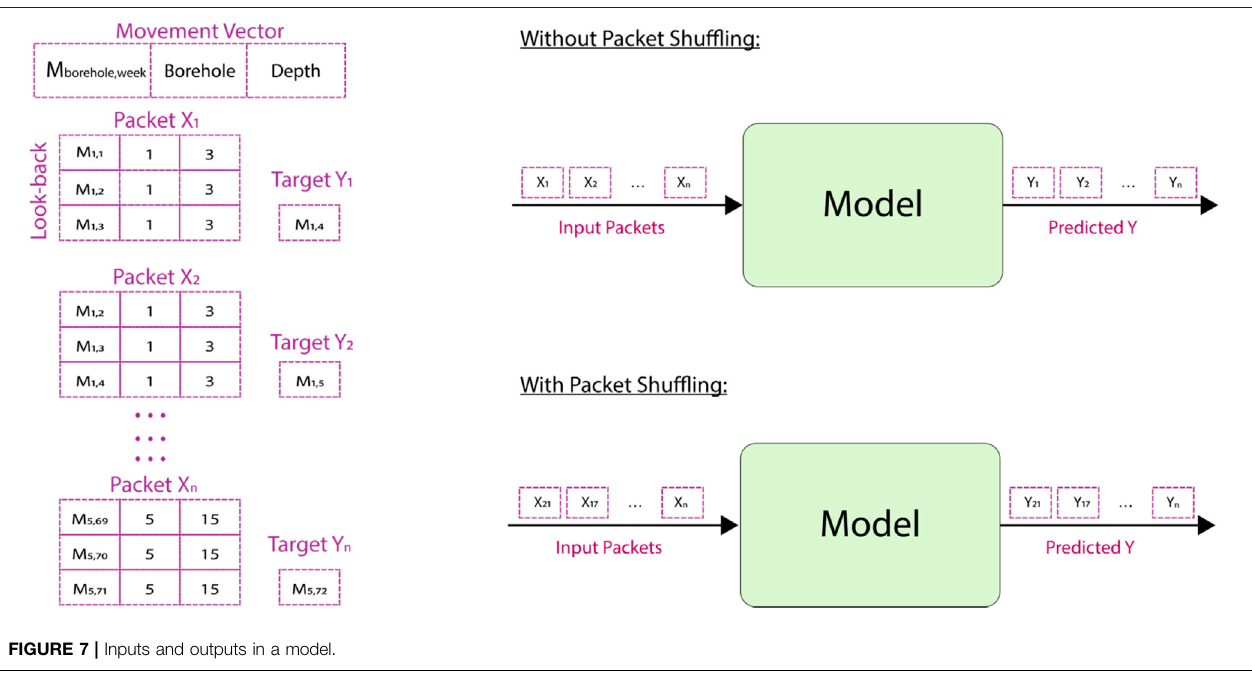
FIGURE 7 | Inputs and outputs in a